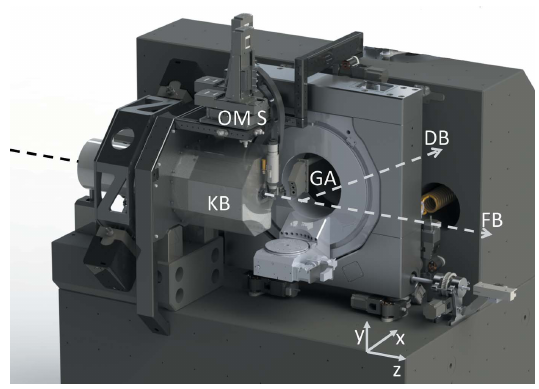
Figure 1 A 3D rendering of the diffraction endstation with laboratory coordinate system ( xyz ). The granite block at the heart of the instrument provides support to the mirror mechanics (KB), the goniometer assembly (GA) and the optical microscopes support (OMS). The directions of the forward X-ray beam (FB) and the diffracted beam (DB) are marked by dashed